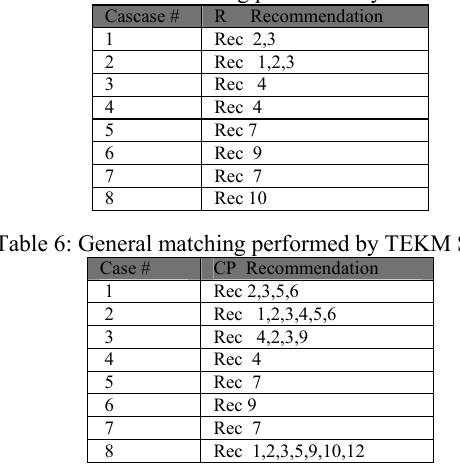
Table 5: General matching performed by domain expert